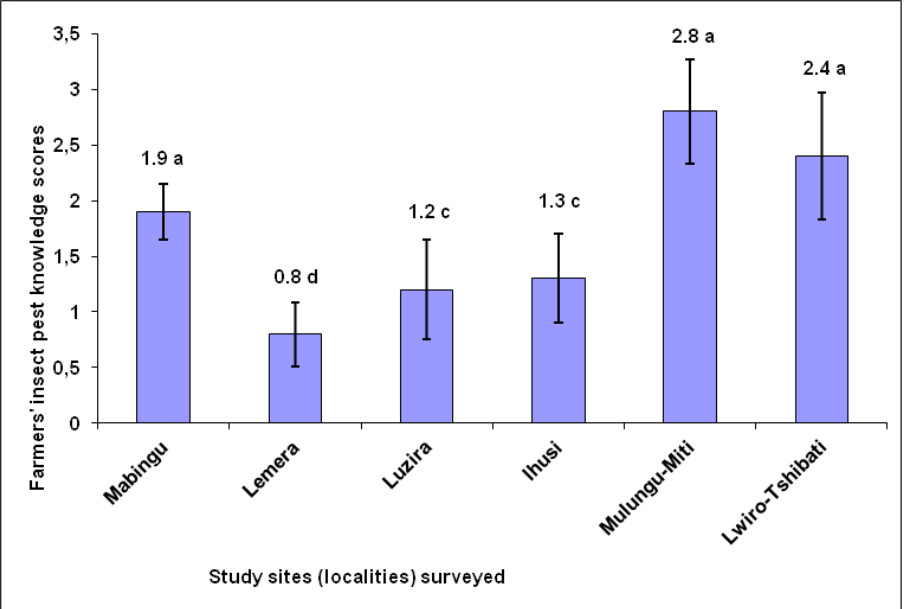
Figure 2: Farmers’ knowledge about insect pests of potato in six study sites of South-Kivu province (eastern DRCongo; 2016 surveys) Scores: 0 = no knowledge, 1 = low knowledge, 2 = medium knowledge, 3 = high knowledge. Bars with the same letter are not statistically different at P ≤ 0.05 Table 5: Perceived mean (x ± se) severity scores for the six major insect pests of potato in six sites, South-Kivu Province, eastern DRCongo (2016 surveys) Study sites Pest species Mabingu Lemera Luzira Ihusi Mulungu-Miti Lwiro-TshibatiOverall Cutworm ( Agrostis spp.) 3.9 ± 0.17